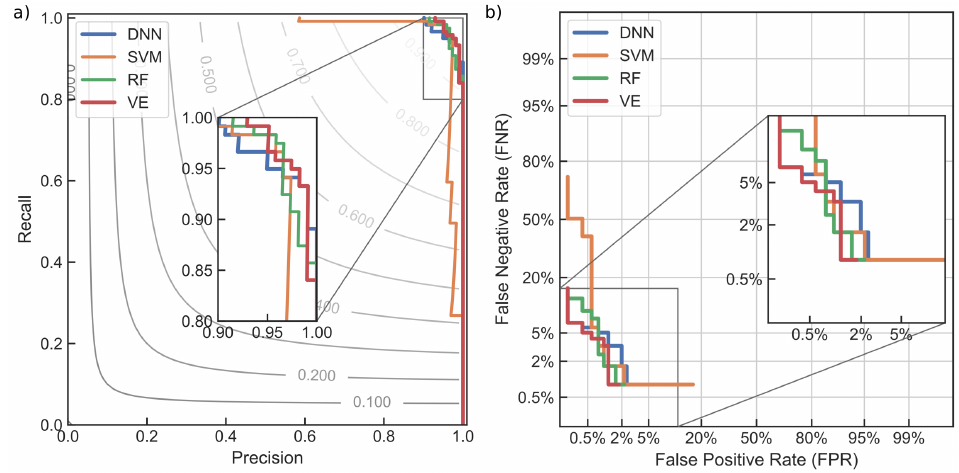
Figure 13. Comparison of DNN, SVM, RF and VE classifiers: ( a ) receiver operating characteristic (ROC) curves presented on top of the isolines of constant F 1 –metric values; ( b ) detection error trade-off (DET) curves plotted in normal deviate scale.